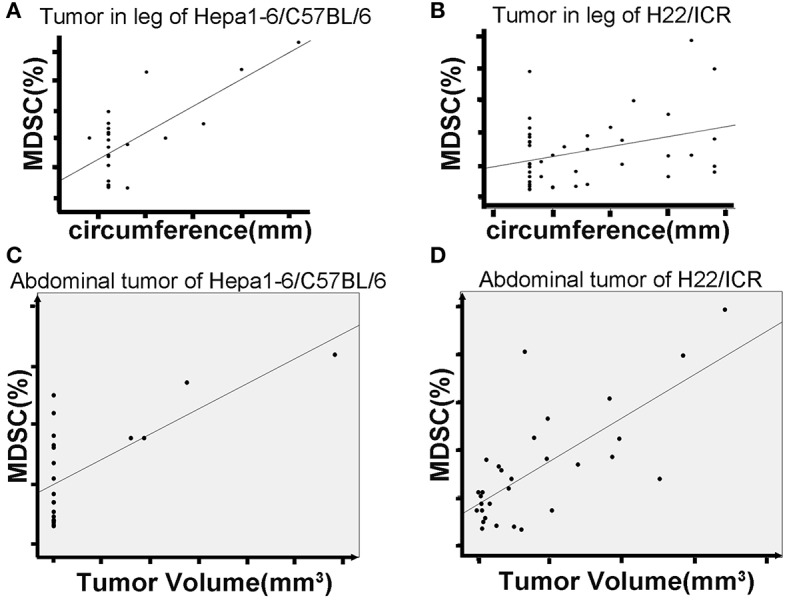
Hypofraction irradiation (IR) reduced blood MDSCs, which was positively correlated with the growth of the tumors. The mice were subcutaneously injected with hepatocellular carcinoma (HCC) cells Hepa1-6 and H22 on one hind limb of each mouse. Three days after the inoculation, the inoculated site was irradiated according to the schedule in Figure 1A. The peripheral blood of the mice was collected from the tail vein. The growth of allogeneic tumors was closely monitored. MDSCs in the blood were measured by flow cytometry. Results showed that the size of on-target tumors is positively correlated with the percentage of MDSCs in total white blood cells (A for Hepa1-6 allogeneic tumor and B for H22 allogeneic tumor) [r2 = 0.716, p < 0.01 in Hepa1-6/C57BL/6 model and r2 = 0.332, p = 0.032 < 0.05 in H22/Institute of Cancer Research (ICR) models]. There was a positive correlation of blood MDSCs with off-target tumor growth (C, D, the Pearson r2 = 0.45, p = 0.041 < 0.05 in Hepa1-6/C57BL/6 model; r2 = 0.529, p = 0.003 < 0.01 in H22/ICR models).